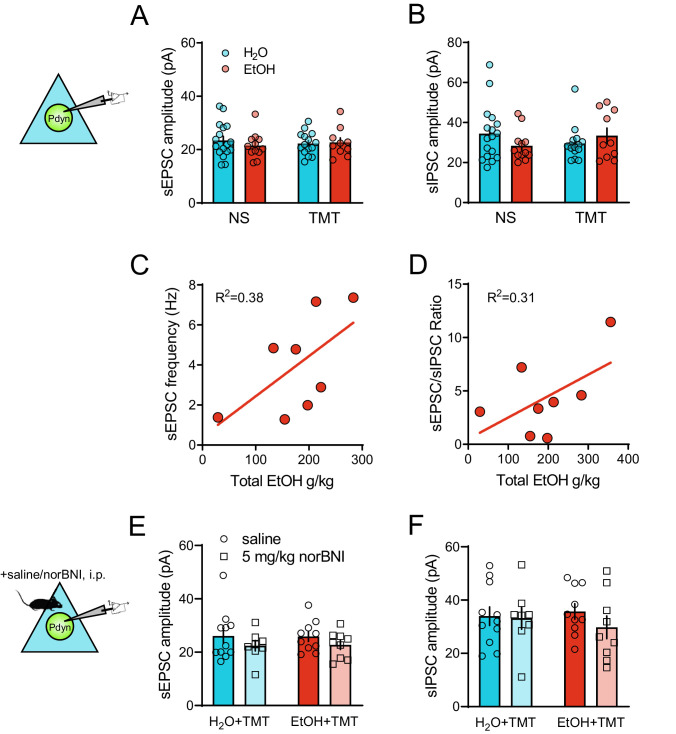
Additional synaptic transmission elements of BNST Pdyn neurons after TMT stress and EtOH drinking.(A) TMT BNSTPDYN cell synaptic transmission sEPSC amplitude (pA). (B) sIPSC amplitude (pA). Correlation between cumulative, total EtOH (g/kg) across six weeks and (C) sEPSC frequency (Hz) and (D), sEPSC/sIPSC ratio in Pdyn-GFP mice after EtOH and TMT. (E) NorBNI pretreatment BNSTPDYN cell sEPSC amplitude (pA). (F) sIPSC amplitude (pA).